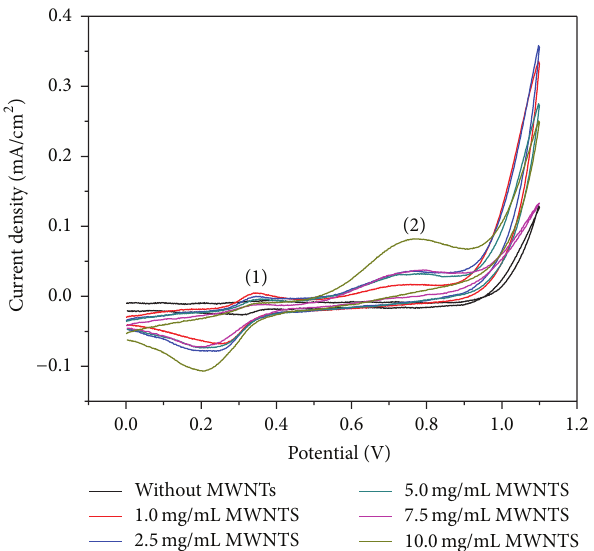
Figure 2: CV traces (selected from the second cycle) during electropolymerization at scan rate of 20mV/s of composite mixtures containing 50 mM ABA and 0, 1.0, 2.5, 5.0, 7.5, and 10.0mg/mL MWNTs in 0.5 MH 2 SO 4 .